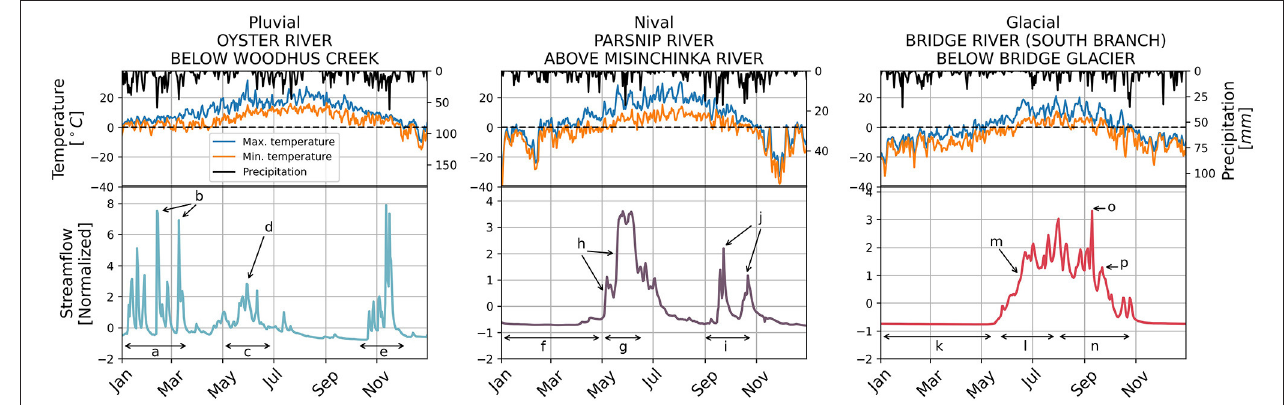
FIGURE 2 | Examples of streamflow, temperature, and precipitation for pluvial, nival, and glacial rivers. Maximum temperature, minimum temperature, and precipitation are taken from ERA5 data at the location of each stream gauge. For the pluvial basin (left panels): (a) Winter pluvial flows are primarily driven by rainfall, but colder temperatures may occur at higher elevation portions of the basin and some precipitation may be stored as snow. (b) Large streamflow events are preceded by precipitation. (c) Spring and early summer pluvial flows may be driven by a small freshet from high elevation snow melt, during which (d) streamflow events can follow dry but warm conditions. (e) Fall pluvial flows are driven by rain and follow precipitation events. For the nival basin (middle panels): (f) Winter and early spring nival flows are suppressed due to below-freezing temperatures. (g) Spring nival flows are driven by snowmelt, and (h) large increases in streamflow follow warm temperatures. (i) Fall nival flows are driven by rainfall, and (j) streamflow events follow precipitation. For the glacial basin (right panels): (k) Winter and early spring glacial flows are suppressed due to below-freezing temperatures. (l) Spring glacial flows are driven primarily by snowmelt, and (m) when warm temperatures drive streamflow. (n) After the snowpack has melted in summer and fall, glacial flows are driven by both rainfall and glacier melt, and streamflow events follow (o) precipitation or (p) warm